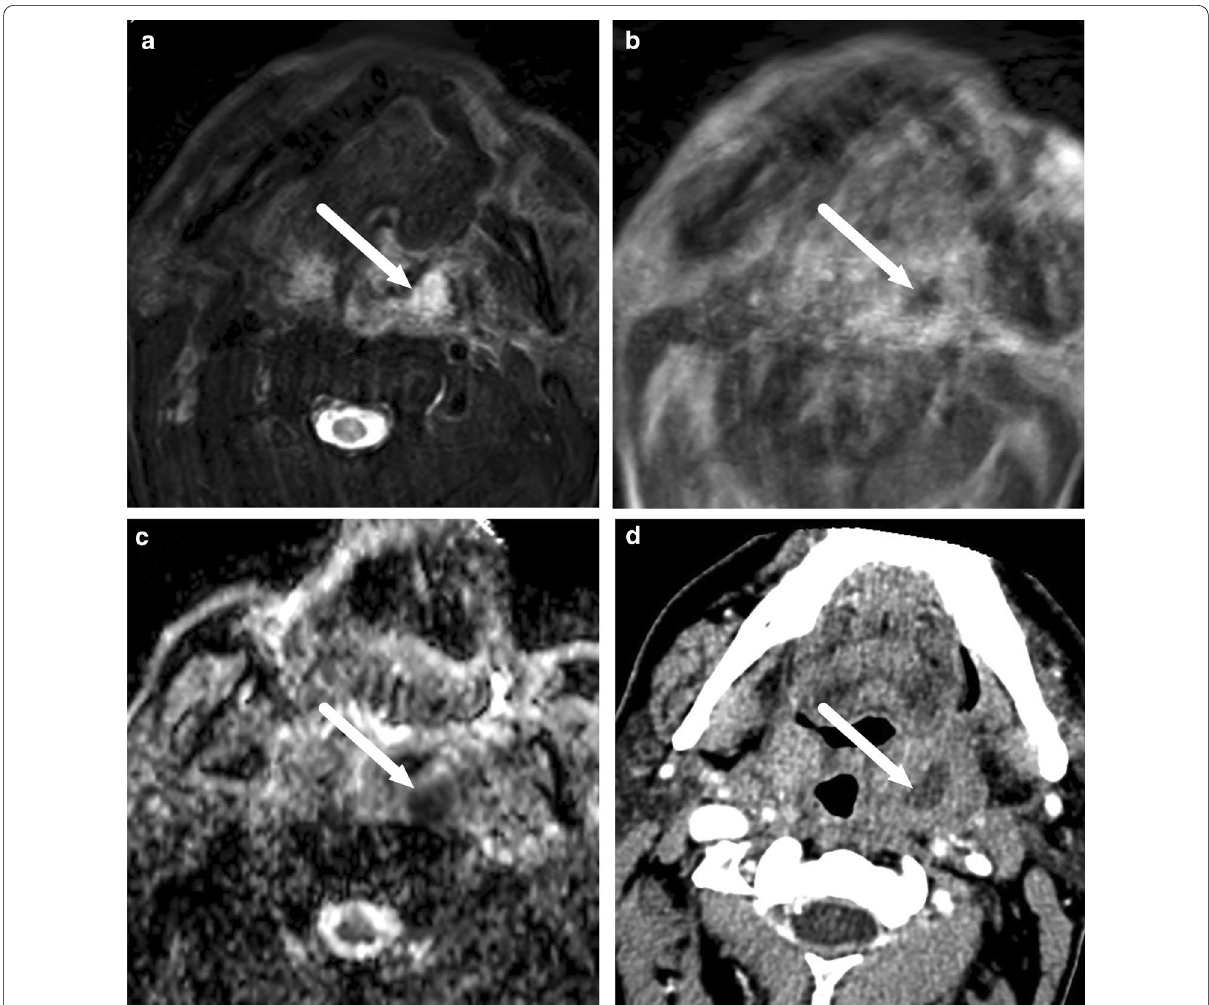
Fig. 25 Excessive patient movement during scanning deteriorating image quality. Axial fat-suppressed T2-weighted ( a ), post-contrast T1-weighted ( b ), and ADC maps ( c ) demonstrate a left-sided PTA (arrows). The radiologist was left unsure about the true extent of the abscess in motion-degraded post-contrast images and recommended CT ( d